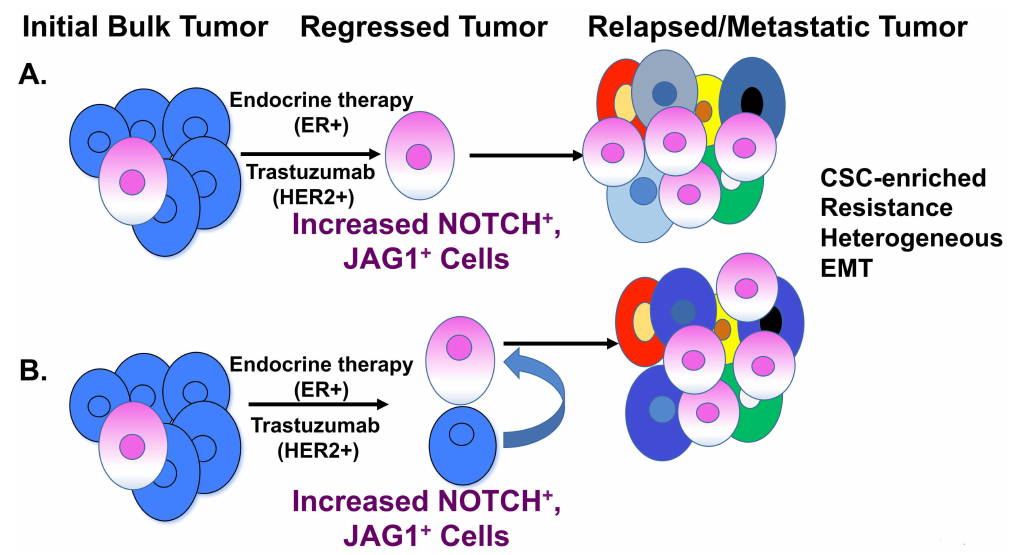
Figure 3. Role of breast cancer stem cells. ( A ) The initial cancer stem-cell hypothesis proposes that a small population of cells exist within the bulk tumor and these cells have inherent stem-like properties of drug resistance, self-renewal, and tumor-initiating potential. Upon treatment with endocrine or HER2-targeted therapy, such as trastuzumab, the majority of the bulk tumor regresses, leaving a small population of cells. These cells have high Notch activity due to increased Notch and / or Jagged1 (JAG1) expression. The Notch-enriched cells are cancer stem cells (CSC) with properties of drug resistance and give rise to a heterogeneous tumor that has undergone epithelial-to-mesenchymal transition (EMT). These CSCs are responsible for tumor relapse and metastatic spread. ( B ) An alternative hypothesis proposes that, upon regression of the bulk tumor, Notch signaling is elevated in both CSCs and non-CSCs. The Notch / Jagged-high-expressing CSCs have properties of self-renewal, drug resistance, and expand into a heterogeneous tumor with more aggressive features. Additionally, non-CSCs may de-di ff erentiate to CSCs under prolonged treatment conditions due to increased Notch and / or Jagged expression. The converted CSCs may give rise to a heterogeneous tumor with drug resistance and metastatic